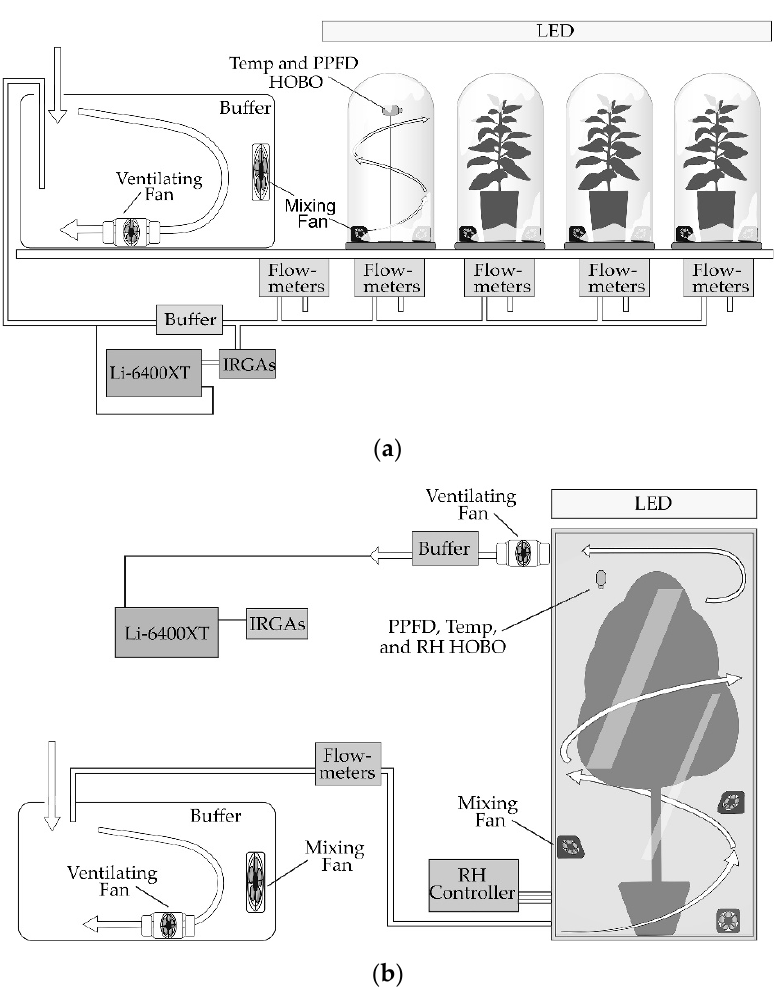
Figure 1. The schematic diagrams of open chamber systems for CAP i measurement of M.9 clones ( a ), and apple scion-rootstock combinations ( b ).